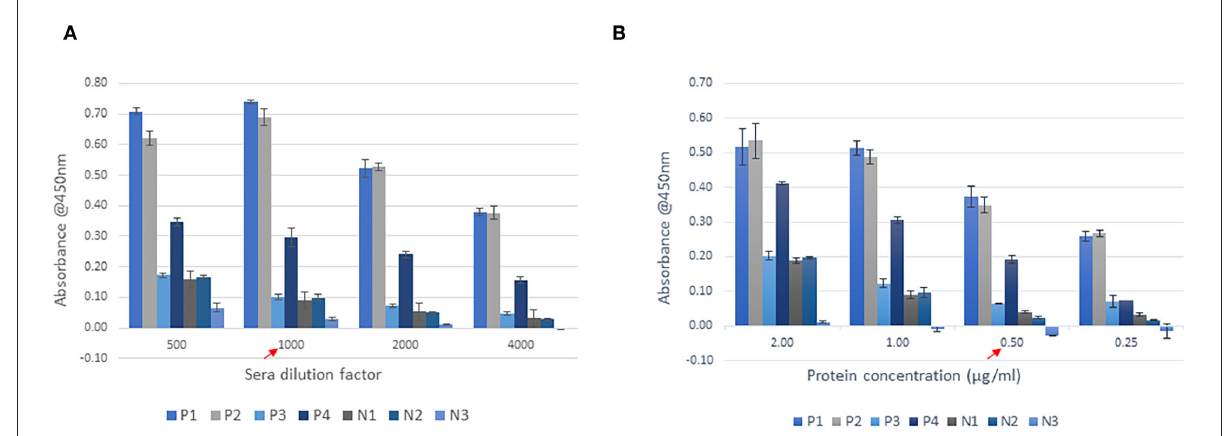
FIGURE5 Optimisation of SLD-ELISA2 parameters. (A) Sera dilution and (B) Protein coating. The red arrows indicate the optimal values.